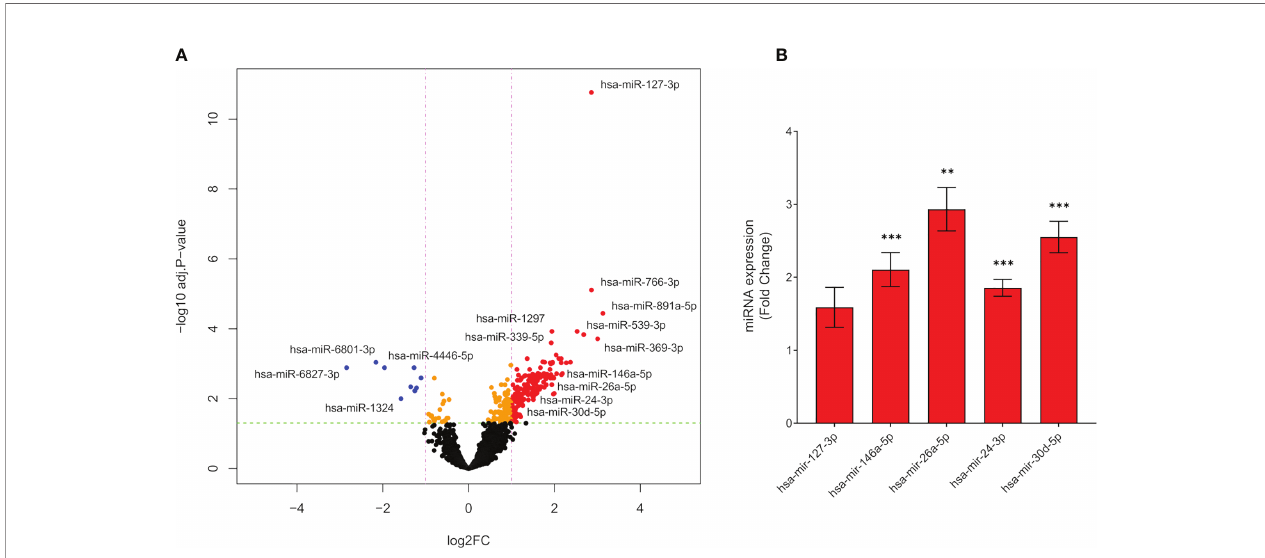
FIGURE 2 | Differentially expressed miRNAs from lactating mothers with type 1 diabetes compared to lactating healthy mothers. (A) Volcano plot of differentially expressed miRNAs in mothers with type 1 diabetes compared to control mothers by RNA-Seq (upregulated miRNAs: red dots, downregulated miRNAs: blue dots). Dotted red lines represent the log2FC cut-off., dotted green lines represent -log10 adjusted p-value cut-off (n=52). (B) mRNA expression by real-time qPCR of miRNA hsa-miR-127-3p, hsa-miR-146a-5p, hsa-miR-26a-5p, hsa-miR-24-3p and hsa-miR-30d-5p in plasma from mothers with type 1 diabetes compared to control. The mRNA expression levels are presented as Fold Change +/- SEM based on 2 - D Ct (n=46), **p < 0.01, ***p <